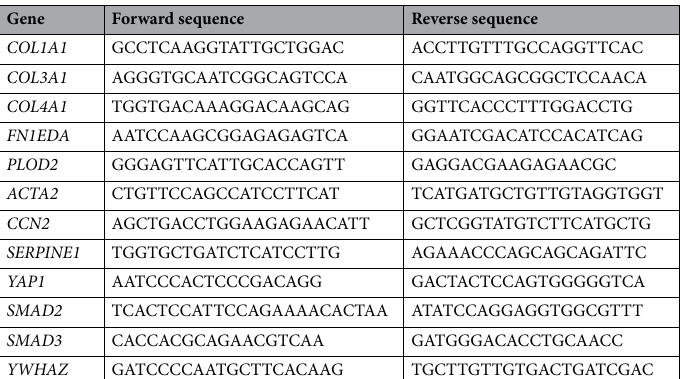
Table 1. Primer sequences used for q-PCR.